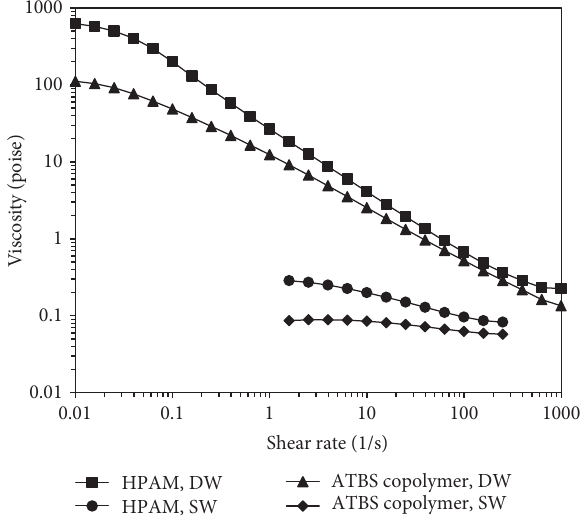
Figure 15: Effect of sea water on steady shear viscosity of HPAM and ATBS-AM copolymer without any surfactant at 50 ∘ C.